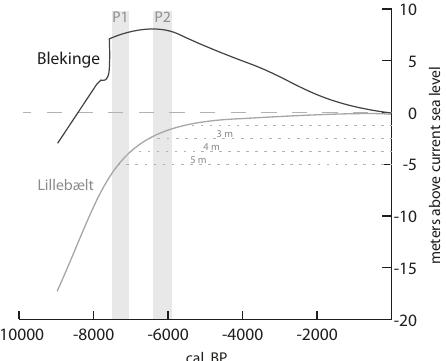
Fig. 1 Sea-level curves from the Baltic Sea. The curve used by Lewis et al. (Blekinge, Sweden) and the more southern curve (Lillebælt, Denmark) over the last 9000 years. P1 and P2 indicate times of increased marine production as suggested by Lewis et al. (data from Rosentau et al. 39 and references